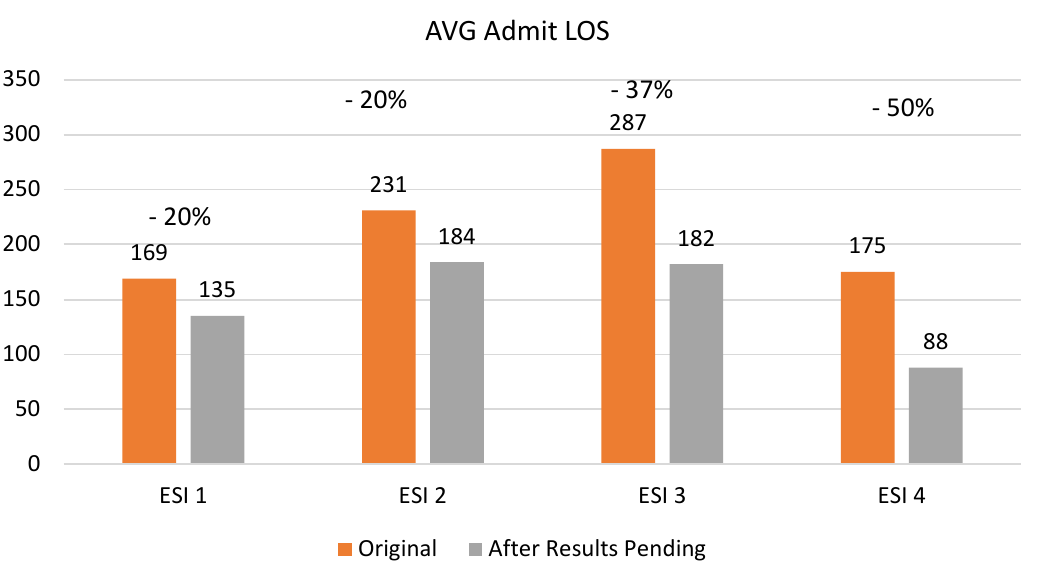
Figure8 Comparisons of average admit patient LOS across the base model and after the results-pending implementation (Image Copyright: